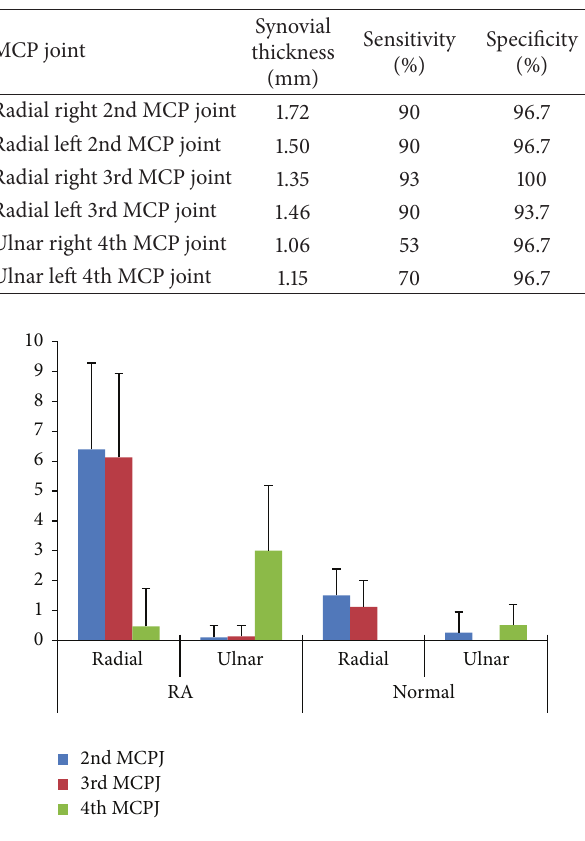
Figure 5: Box plot presentation of synovial thickness distribution of 2nd, 3rd, and 4th MCPJ in RA patients and healthy control